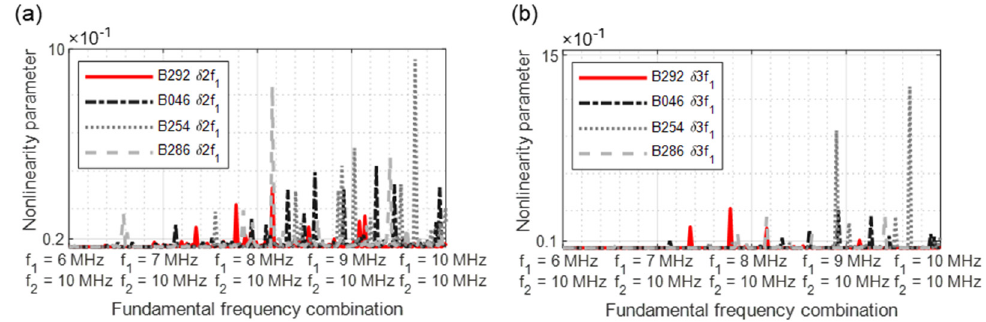
Figure 30. Nonlinearity parameter: ( a ) δ 2f 1 ; ( b ) δ 3f 1 .